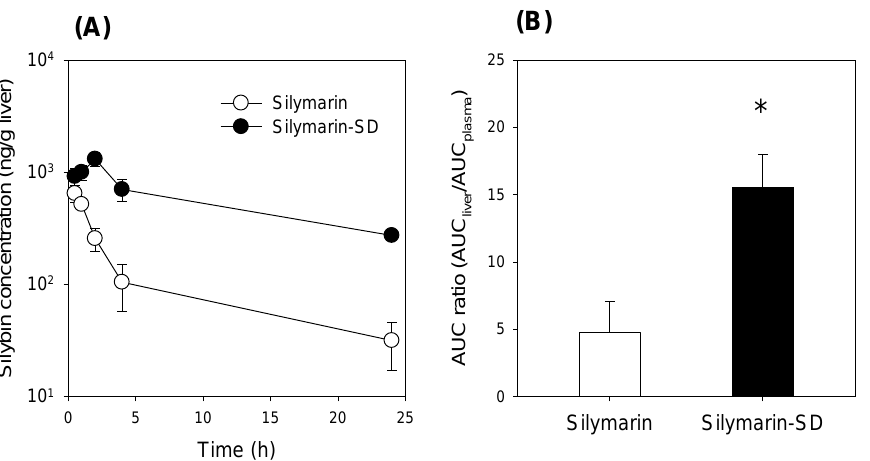
Figure 6. ( A ) Silybin concentrations in the liver. ( B ) Liver to plasma AUC ratio of silybin after the repeated oral administration for five consecutive days of silymarin (20 mg/kg as silybin) and silymarin-SD (20 mg/kg as silybin) in rats with APAP-induced hepatotoxicity. Treatment followed the dosing schedule in Figure 1. Each data represents mean ± standard deviation of four rats at individual time point per group. * p < 0.05, compared with silymarin group.